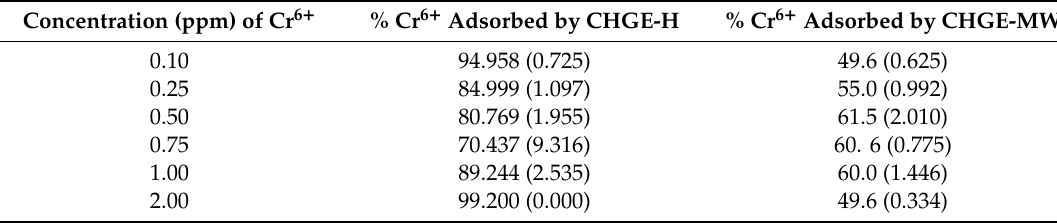
Table 4. Cr 6 + percentage adsorbed by 0.5 g of CHGE in contact with the distilled water solution for 24 h, as a function of the concentration (ppm) of Cr 6 +